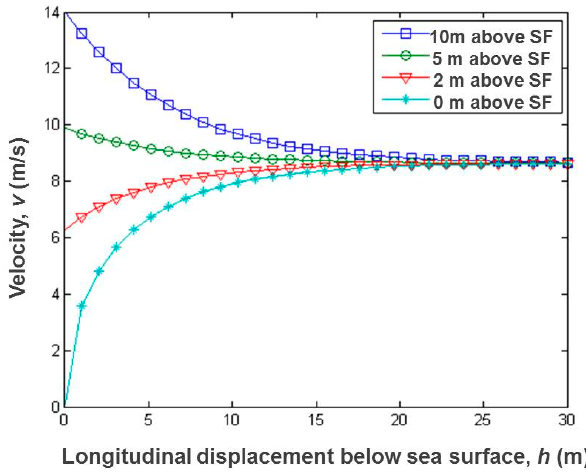
Figure 6. Anchor speed while anchoring at di ff erent altitudes.